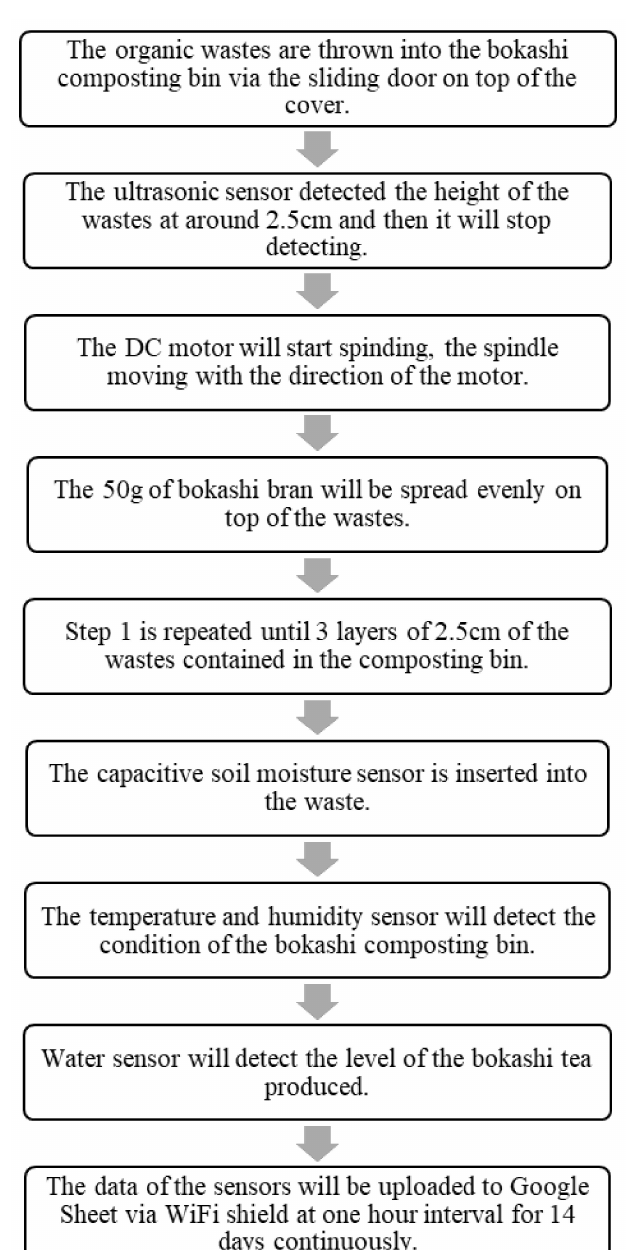
Figure 2. The operating procedures of the bokashi composting bin. The sensors are connected to the ATmega328 microcontroller, and the sensors’ param- eters are uploaded to Google Sheet at 1 h interval using Arduino WIFI Shield. The Arduino WIFI Shield model ESP8266 was attached to the ATmega328 microcontroller, as shown in user instructions. The function of Arduino WIFI Shield ESP8266 allows the ATmega328 microcontroller to connect to any WIFI connection. Hence, the data collected from the sensors can be uploaded to the Internet via WIFI protocol. The pins of the Real-Time Clock were connected to pin 5V, Ground, SDA, and SCL. SDA pin and SCL pin were dedicated to the ATmega328 microcontroller board. Besides that, the signal of the temperature and humidity sensor was connected to pin